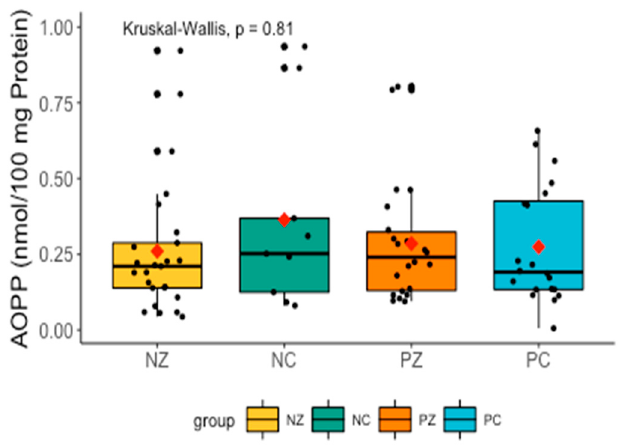
Figure 7. Levels of AOPP in the saliva of the examined women. AOPP, advanced oxidation protein products; NZ, generally healthy patients without the BRCA1 mutation; NC, patients with breast cancer but without the BRCA1 mutation; PZ, generally healthy patients with the BRCA1 mutation; PC, patients with both breast cancer and the BRCA1 mutation.